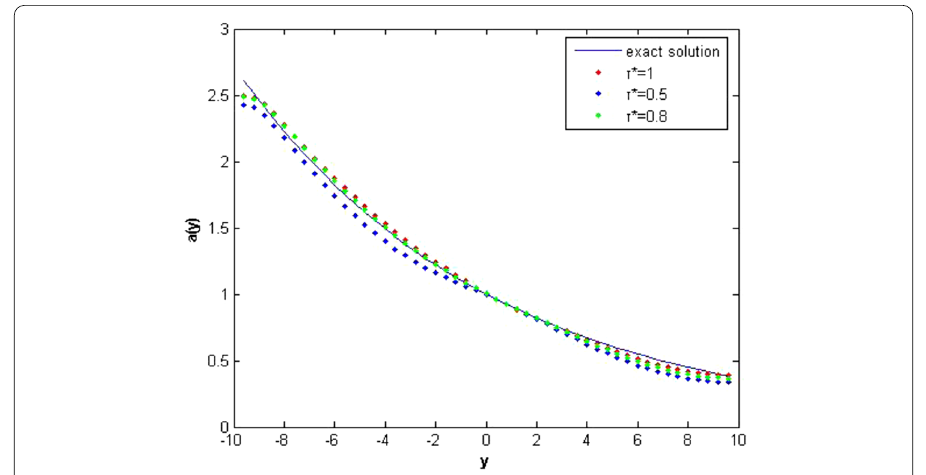
Figure 4 Noiseless case for Example